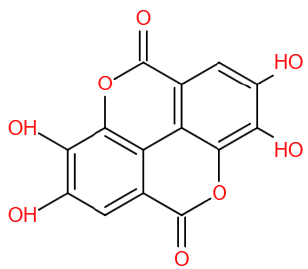
Figure 1. The chemical structure of EA.